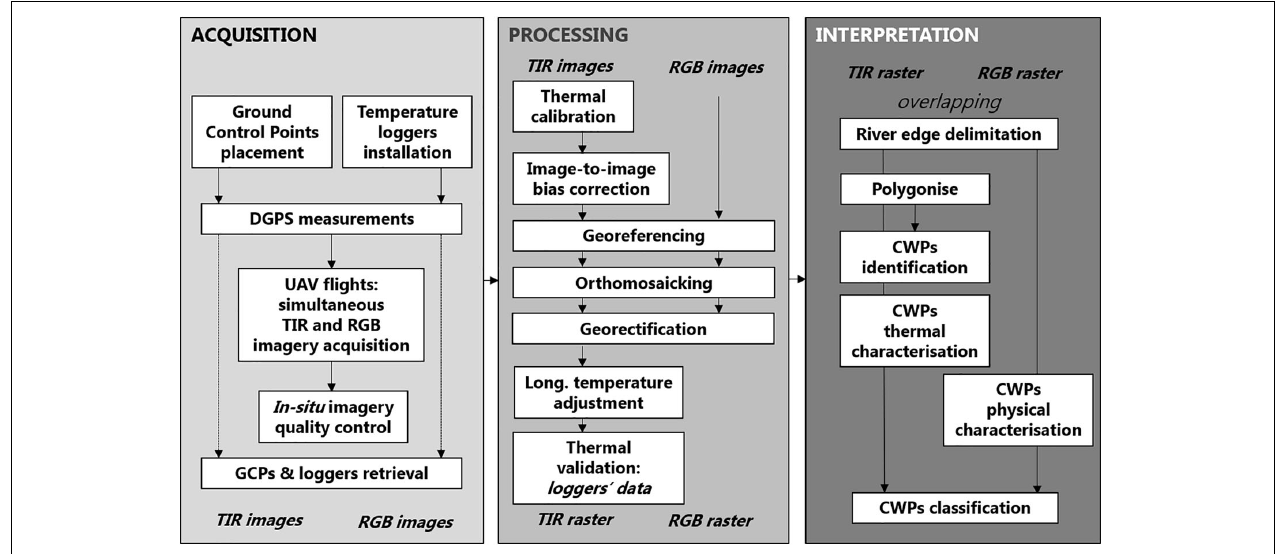
FIGURE 2 | Diagram of the methodological approach for UAV-based TIR and optical (RGB) imagery data acquisition, processing, and interpretation.